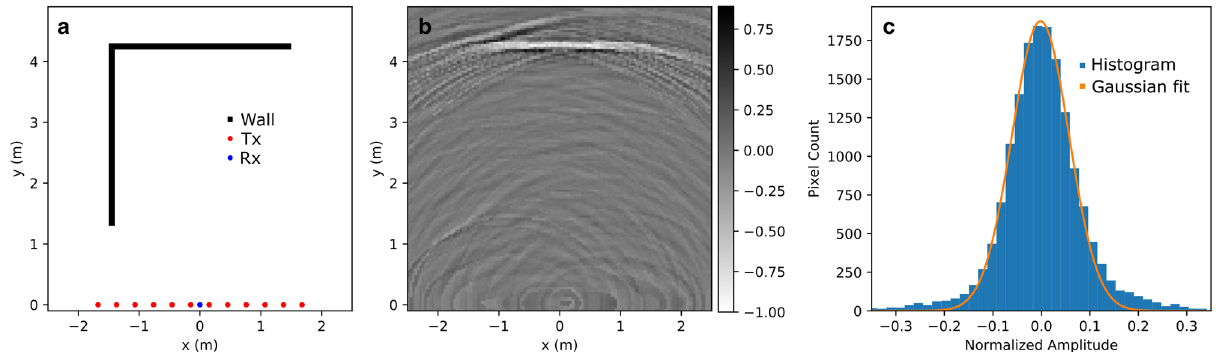
Fig. 4 Numerical evaluation of image reconstruction model. The simulated scene in panel a shows the two walls (black), the position of the transmitters (red) and the receiver (blue), and the fi rst-order reconstructed image using Eq. (2) with its corresponding gray scale bar in panel b . In panel c , the histogram of the normalized image pixels in blue is fi tted by a Gaussian in